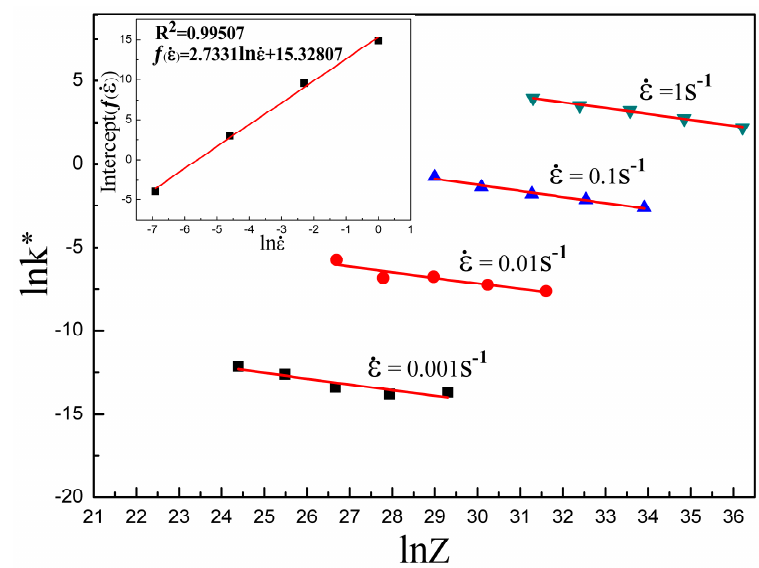
∗ k Z parameter and . These linear curves are obtained Z parameter is in the form of . ε and the intercepts of these linear ε  and the intercepts of these